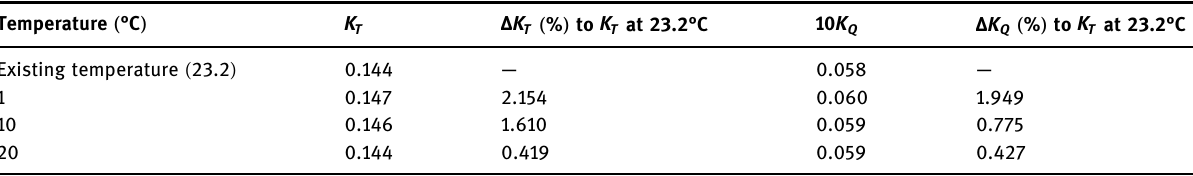
Table 10: Comparison of coe ffi cient of thrust and torque for case 3 J σ